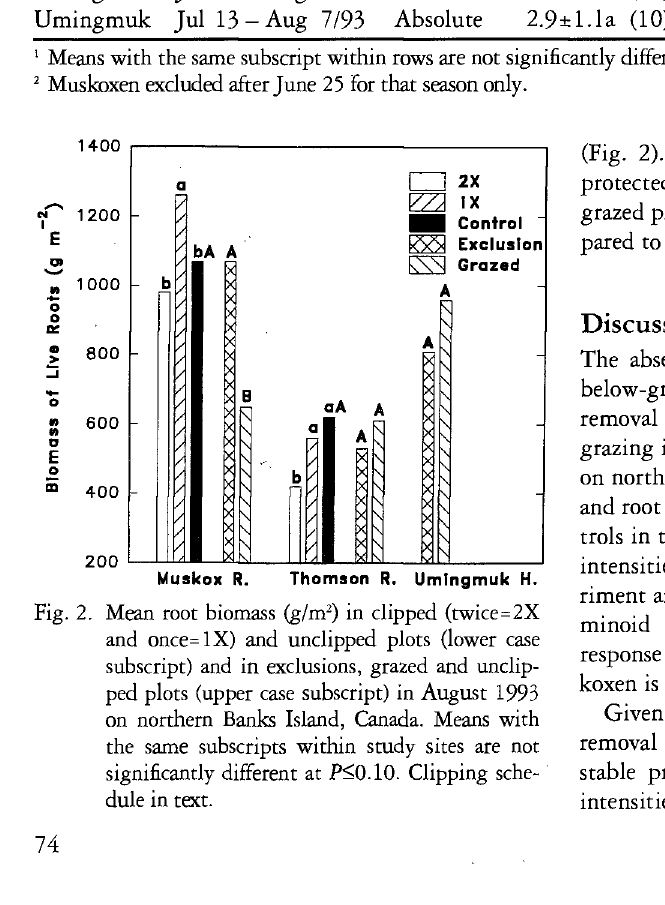
Fig. 2. Mean root biomass (g/m 2 ) in clipped (twice=2X and once = IX) and undipped plots (lower case subscript) and in exclusions, grazed and undip ped plots (upper case subscript) in August 1993 on northern Banks Island, Canada. Means with the same subscripts within study sites are not significantly different at P<0.10. Clipping sche dule in text.